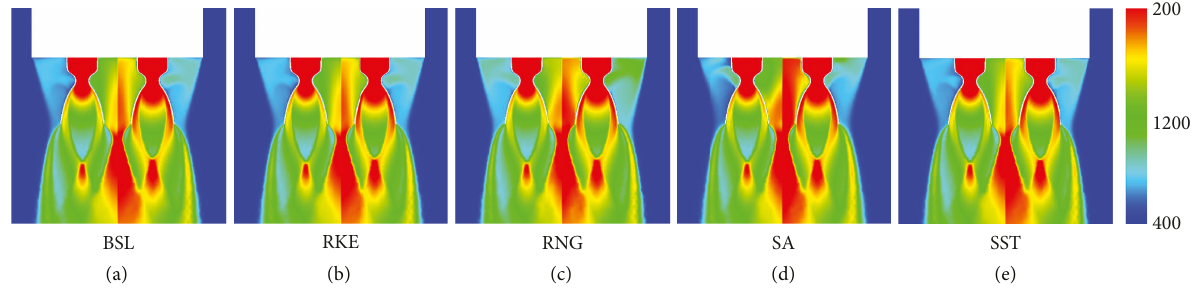
Figure 8: Static temperature contours between frozen fl ow (left half) and fi nite-rate chemistry (right half) for di ff erent turbulence